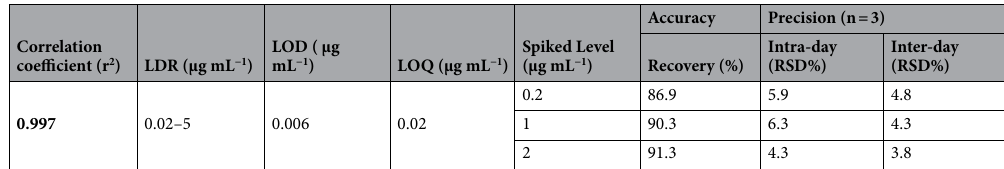
Table 3. Analytical characteristics of the